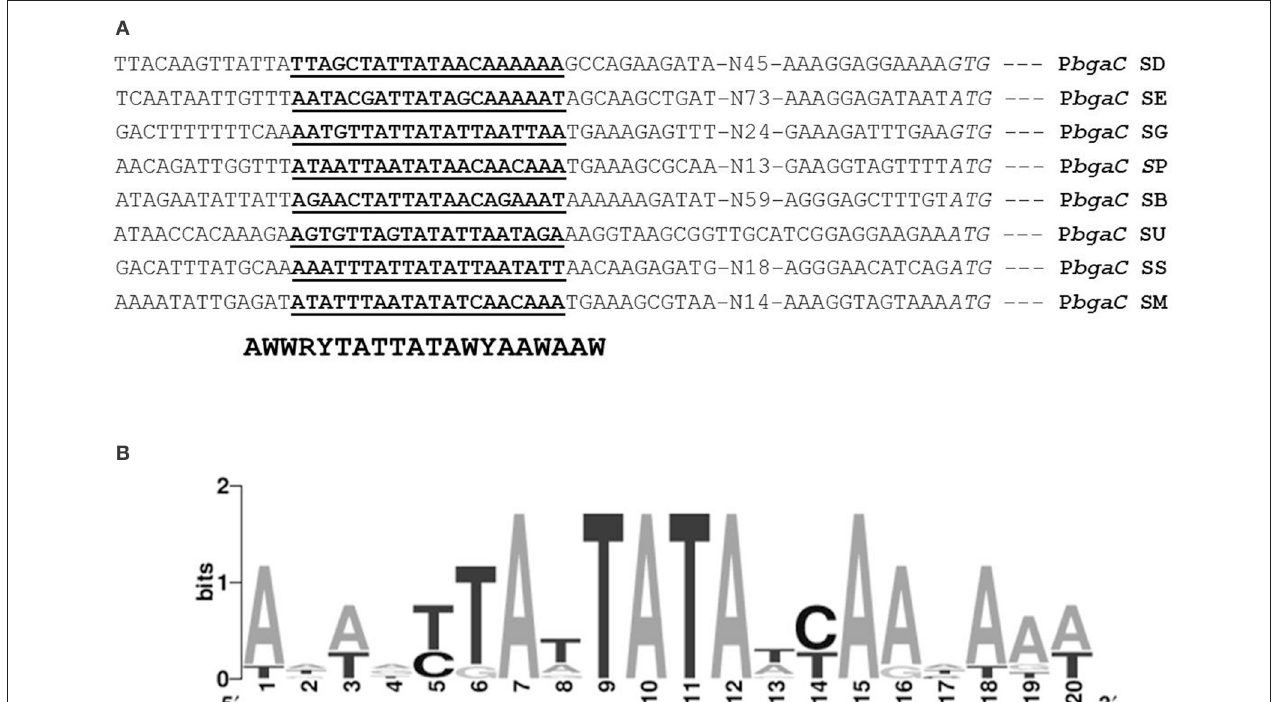
FIGURE 3 | Identification of the AgaR operator site in P bgaC . (A) Position of the AgaR operator site in P bgaC of different streptococci. Translational start sites are italicized and putative AgaR operator sites are bold-underlined. (B) Weight matrix of the identified AgaR operator site in the P bgaC of different streptococci. SD, S. dysgalactiae ; SE, S. equi ; SG, S. gordonii ; SP, S. pneumonia ; SB, S. uberis ; SU, S. suis ; SS, S. sanguis; and SM, S. mitis .